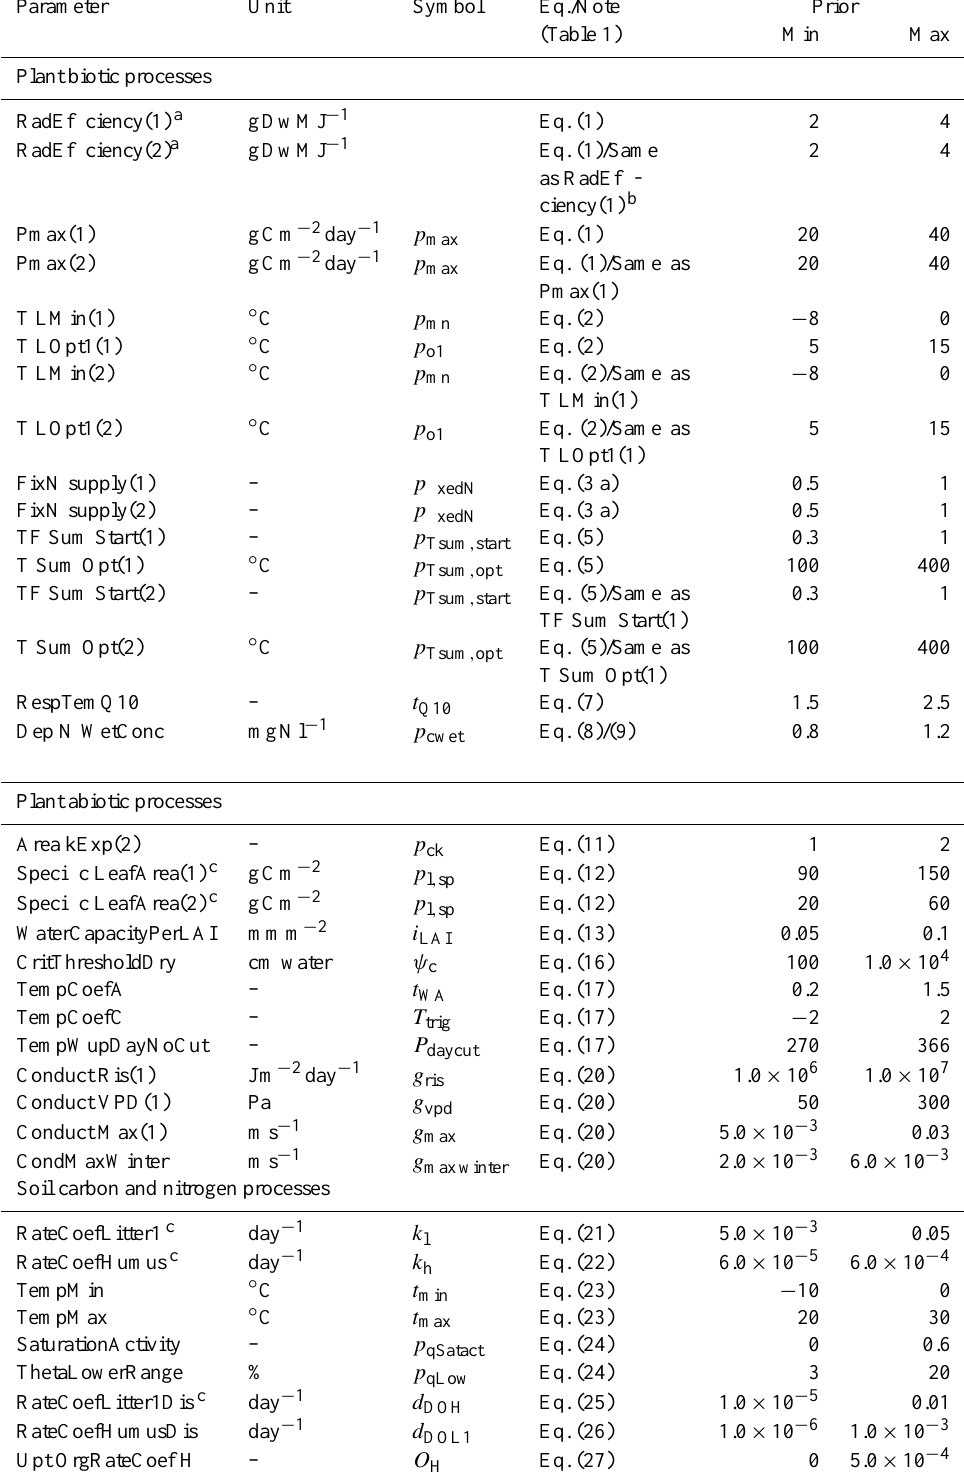
(Table 1) Min Max